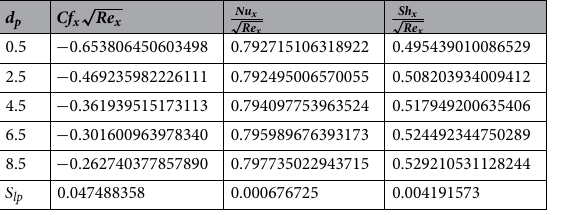
10 and D 100 , S r = ∞ =